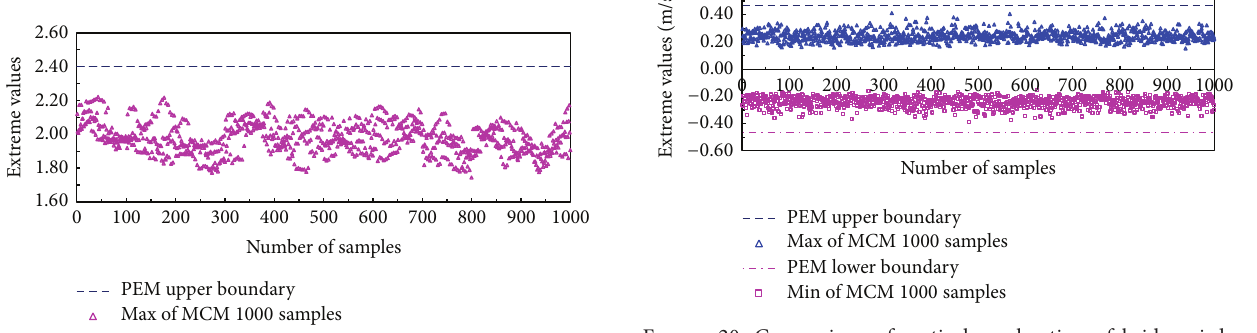
Figure 16: Comparison of Sperling’s ride index of trailer car.